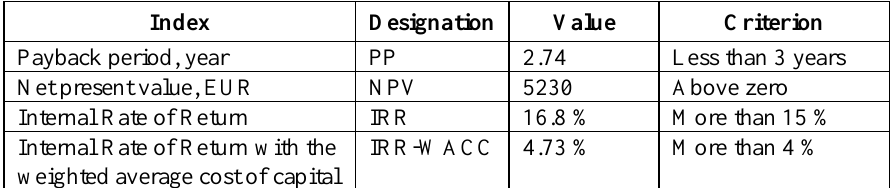
Table 2. Evaluation of the Effectiveness of the Integration of the PIM System over a Three-Year Period (authors’ developed) Index Designation Value Criterion Payback period, year PP 2.74 Less than 3 years Net present value, EUR NPV 5230 Above zero Internal Rate of Return IRR 16.8 % More than 15 % Internal Rate of Return with the weighted average cost of capital